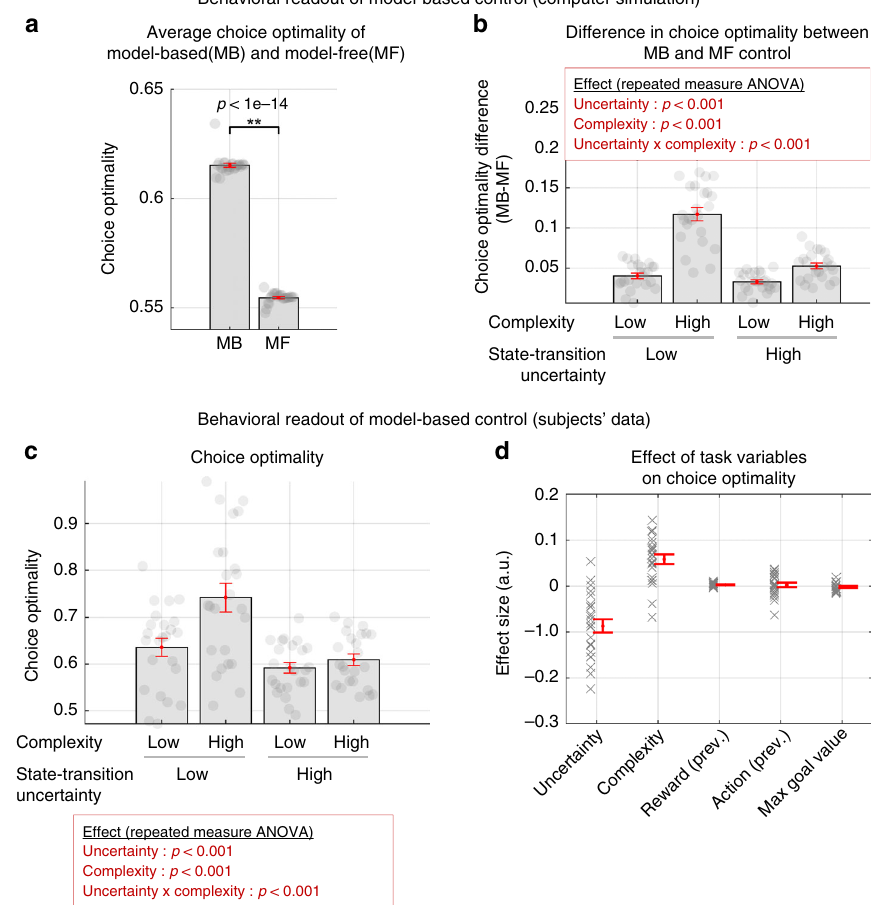
Fig. 3 Behavioral results — choice optimality. a Choice optimality (a proxy for assessing the degree of agents ’ engagement in model-based control) of a model-based and model-free RL agent. Each MB and MF model simulation (that generates each one of the data points) was produced using free parameters derived from separate fi ts of each of these models to each individual participant ’ s behavioral data in the study. Choice optimality depicts the degree of match between agents ’ actual choices and an ideal agent ’ s choice corrected for the number of available options. For full details of this measure, refer to Methods. b Difference in choice optimality between an MB and MF agent for the four experimental conditions (low/high state-transition uncertainty × low/high-task complexity). Shown in red boxes are the effect of the two experimental variables on each measure (two-way repeated measures ANOVA). c Participants ’ choice optimality for the four experimental conditions. Shown in red boxes are the effect of the two experimental variables on each measure (two-way repeated measures ANOVA; also see Supplementary Table 3 for full details). d Results of a general linear model analysis (dependent variable: choice optimality, independent variables: uncertainty, complexity, reward values, choices in the previous trial, and goal values). Uncertainty and complexity, the two key experimental variables in our task, signi fi cantly in fl uence choice optimality (paired t -test; p < 0.001). Error bars are SEM across